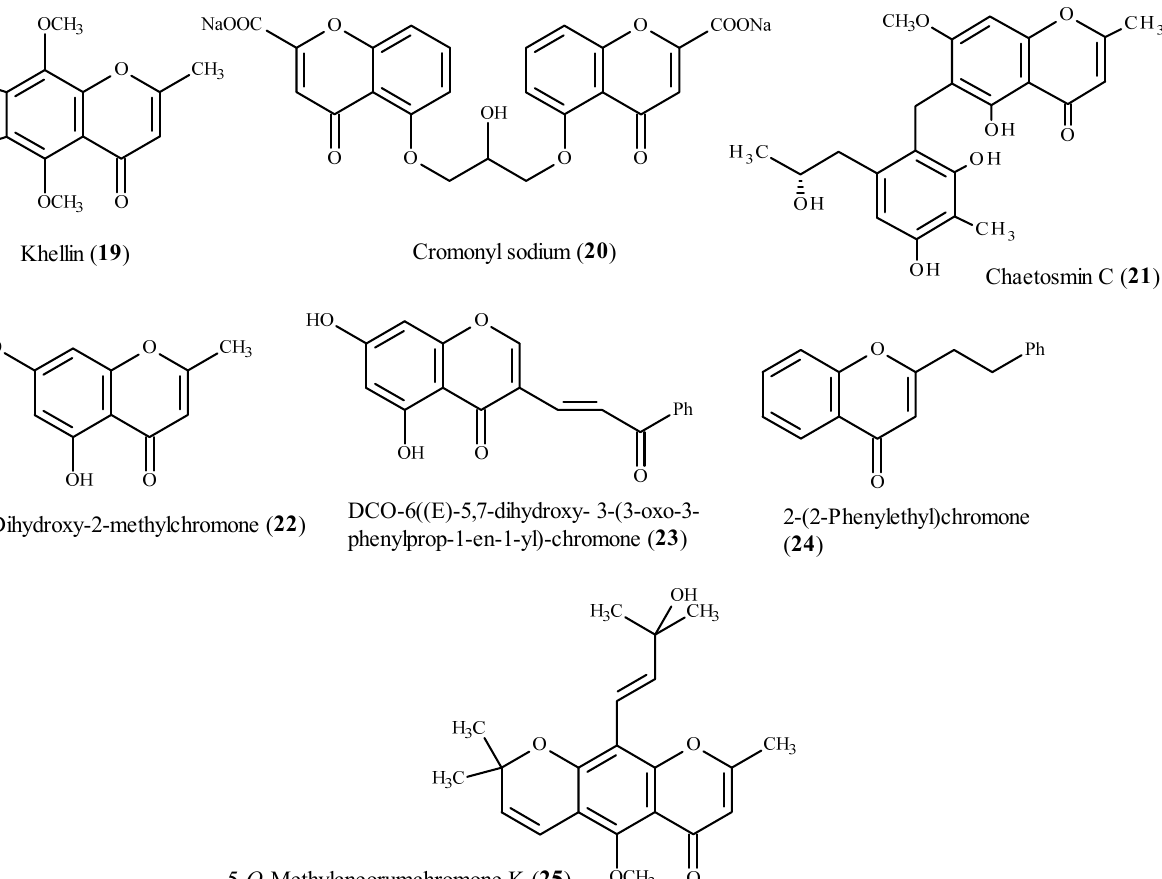
Figure 3. Structures of chromone derivatives mentioned in the Section 5.3.